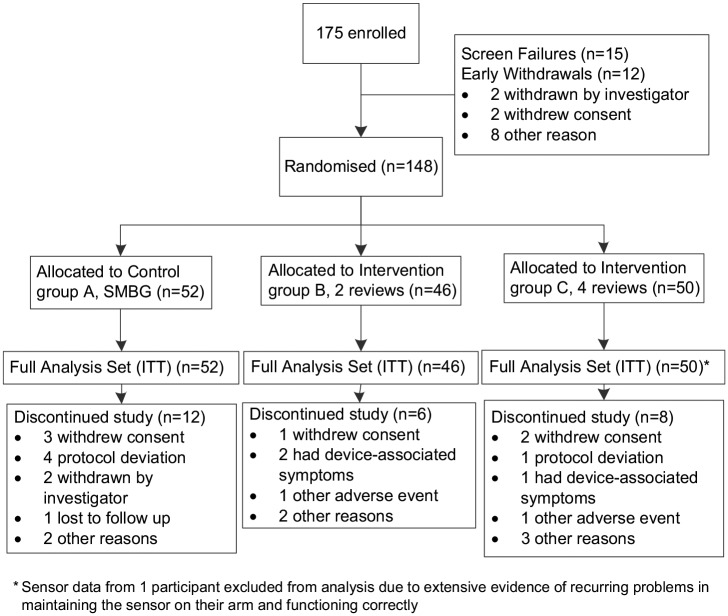
Trial profile demonstrating withdrawal rate.